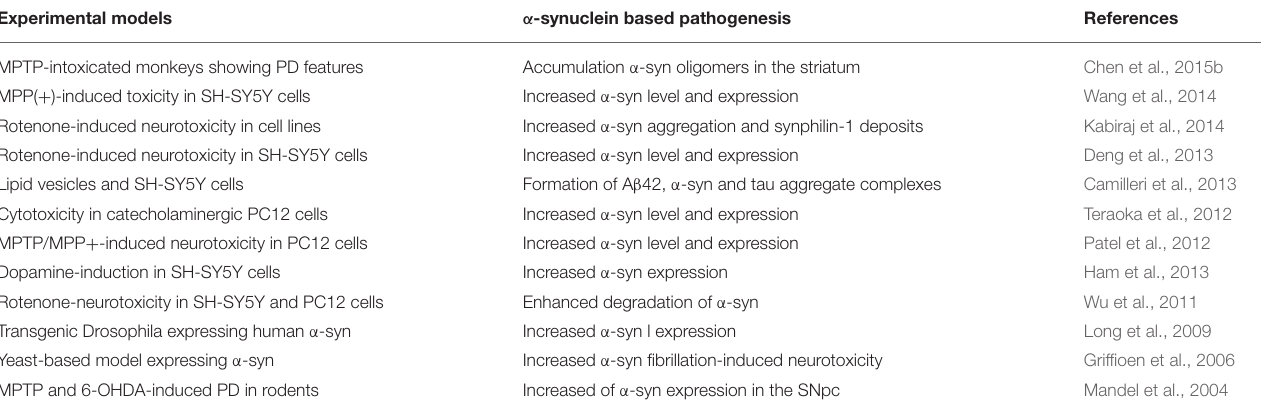
TABLE 7 | The experimental models used to evaluate plant extracts and phytochemicals against neurotoxicity mediating α -synuclein oligomerization, and fibrillation. Experimental